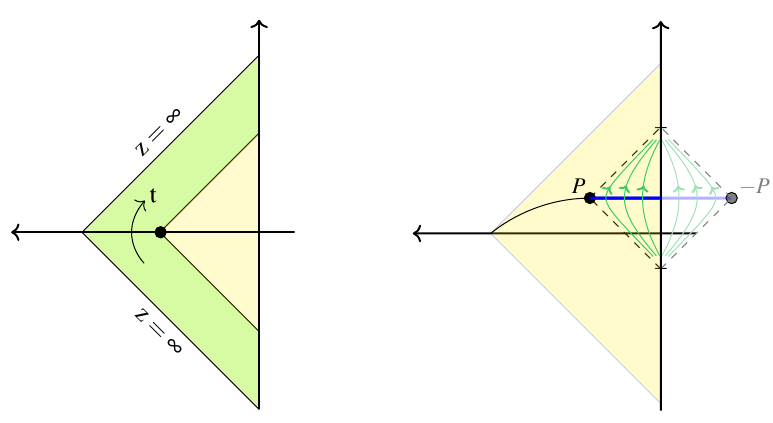
Figure 4 . Left : the AdS 2 -black hole solution of JT (yellow) and the Poincar(cid:19)e solution (largest triangular region), described by Poincar(cid:19)e covering coordinates t and z. The Killing vector (cid:24) JT associated with the Killing horizon of the black hole solution vanishes at the point t = 0 ; z = 1 p (cid:22) g f labeled by the dot. The boundary is at z = 0. The coordinate axes refer to global AdS 2 coordinates, see e.g. [23, 24]. Right : the AdS 2 -black hole solution has a metric Killing vector (cid:24) g , with (cid:13)ow lines in green, that vanishes in P . The point P at location ( X + ; X (cid:0) ) or (t = t 0 ; z = R ) in Poincar(cid:19)e covering coordinates marks the boundary @ (cid:6) of the interval (cid:6) = [ P , boundary z = 0] (in blue). Imposing re(cid:13)ective boundary conditions at z = 0, the interval can be e(cid:11)ectively doubled to a region with diamond-shaped domain of dependence (cid:5)